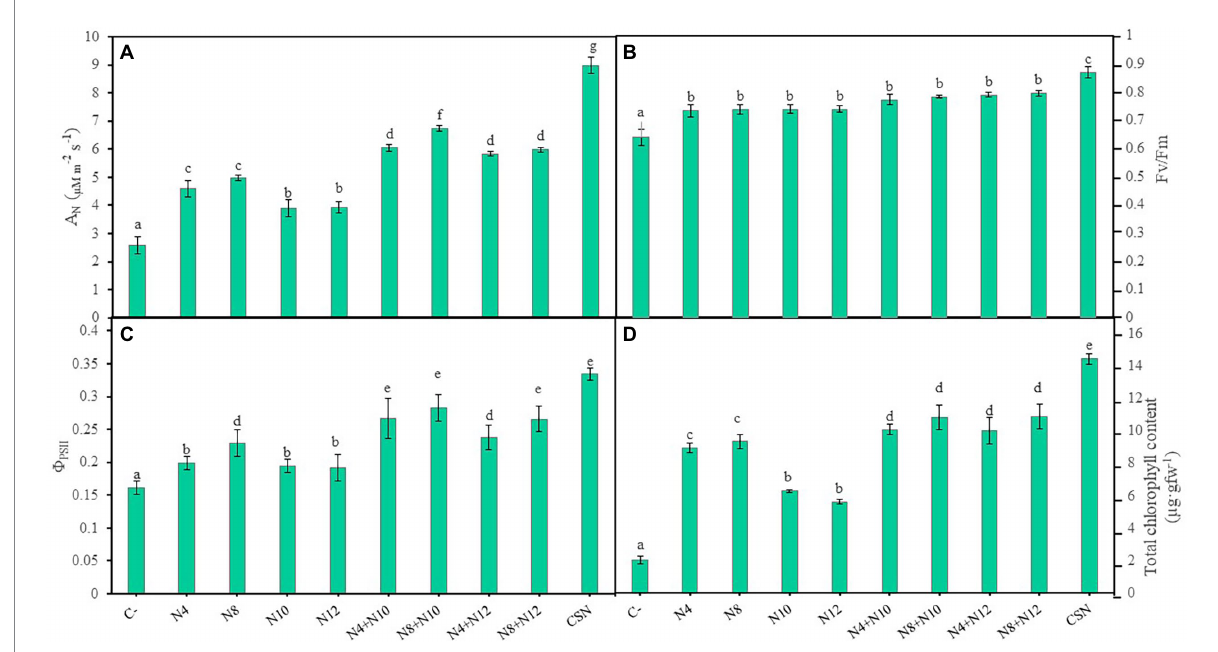
FIGURE 4 Photosynthetic parameters of M. sativa plants inoculated with PGPNE. (A) Net photosynthetic rate (A N ), (B) maximum quantum efficiency of PSII photochemistry (Fv/Fm), (C) quantum yield of PSII photochemistry ( Φ PSII ), and (D) total chlorophyll content after 60 days in pots containing soil from the high marshes of the Odiel River. Values are means ± S.D. ( n = 16). Different letters indicate statistical differences between means (One-way ANOVA, LSD test, p < 0.0001). C-: non inoculation; N4: inoculation with Pseudomonas sp. N4; N8: inoculation with Pseudomonas sp. N8; N10: inoculation with Ensifer sp. N10; N12: inoculation with Ensifer sp. N12; N4 + N10: co-inoculation with Pseudomonas sp. N4 and Ensifer sp. N10; N8 + N10: co-inoculation with Pseudomonas sp. N8 and Ensifer sp. N10; N4 + N12: co-inoculation with Pseudomonas sp. N4 and Ensifer sp. N12; N8 + N12: co-inoculation with Pseudomonas sp. N8 and Ensifer sp. N12; CSN: inoculation with Pseudomonas sp. N4, Pseudomonas sp. N8, Ensifer sp. N10 and Ensifer sp.